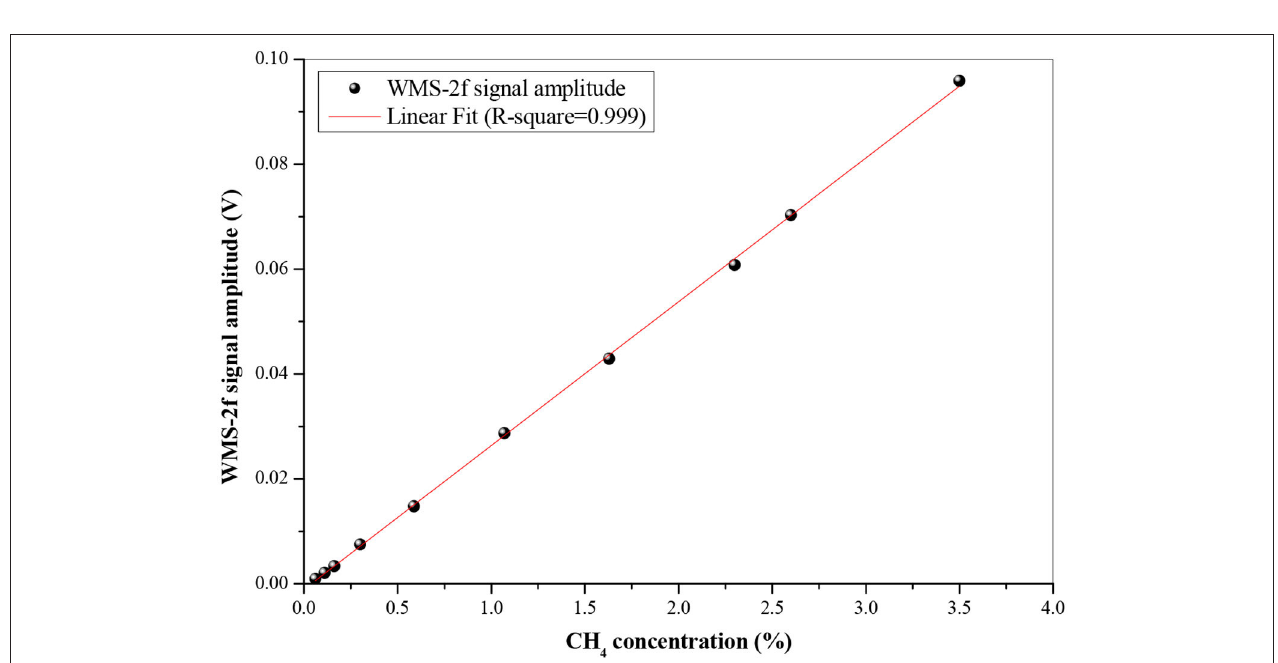
FIGURE 6 | The relationship of CH 4 gas concentration and WMS-2 f signal amplitudes. The line is the best linear fit.